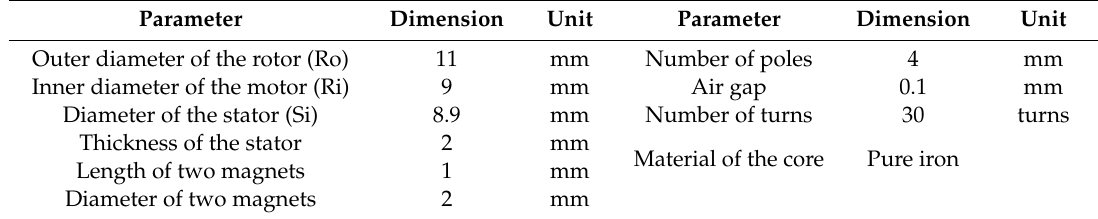
Table 3. Parameters of the wobble